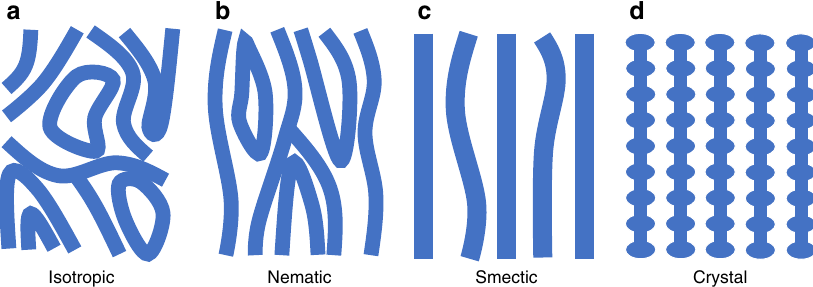
Fig. 1 Cartoon of electronic liquid-crystal phases at half- fi lling. a Isotropic liquid. b Nematic liquid crystal. c Smectic liquid crystal. d Anisotropic stripe crystal (after Kivelson, Fradkin, and Emery 16 ). Blue regions indicate high fi lling factor (i.e., high density of electron guiding centers) and white regions indicate low fi lling